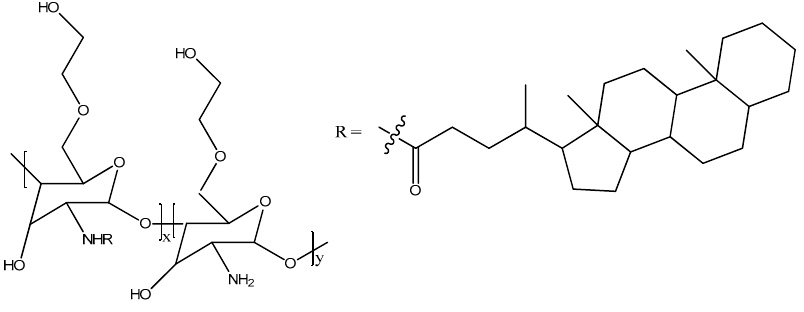
Figure 5. Chemical structure of glycol chitosan modified with cholanic acid.